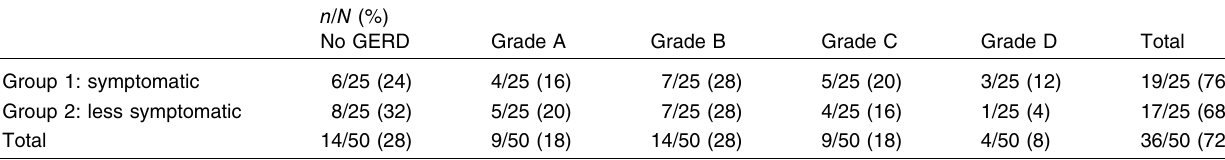
Table 4 Endoscopic evidence of GERD in both groups Asthma control level Controlled Partially controlled Uncontrolled Total Number and percentage of GERD in group 1 (symptomatic patients) Number and percentage of GERD in group 2 (less symptomatic